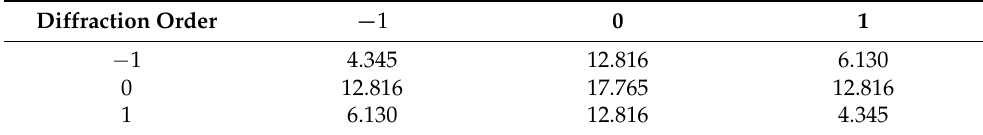
Table A1. Diffraction efficiencies (%) of the transmitted orders of the checkerboard grating studied in